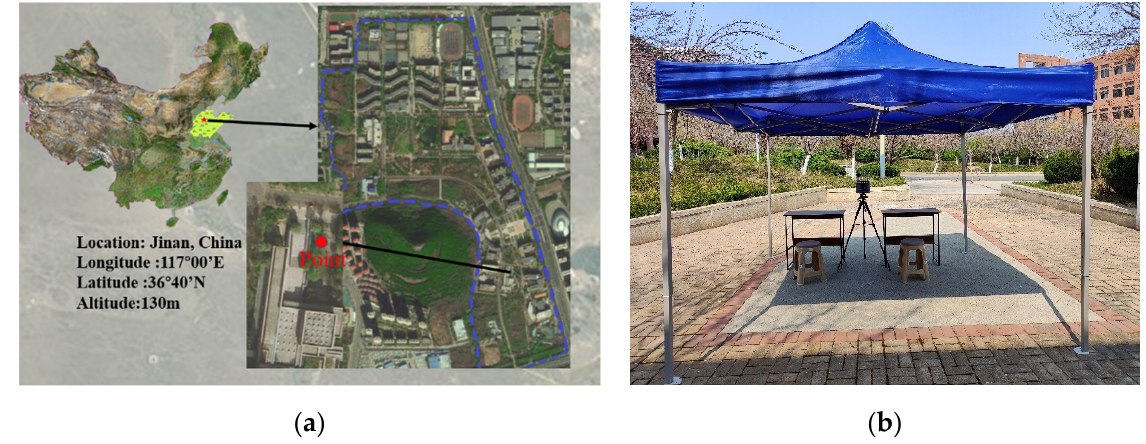
Figure 1. Pictures of the experiment site. ( a ) Location of the testing site. ( b ) Layout of the experimental site.